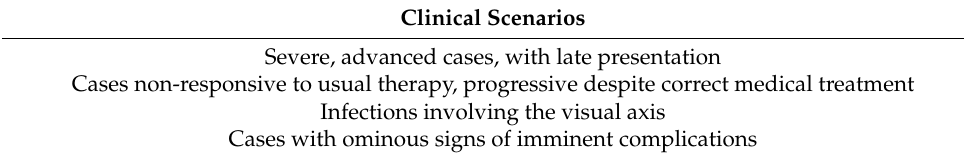
Table 2. Clinical scenarios where CXL was employed.